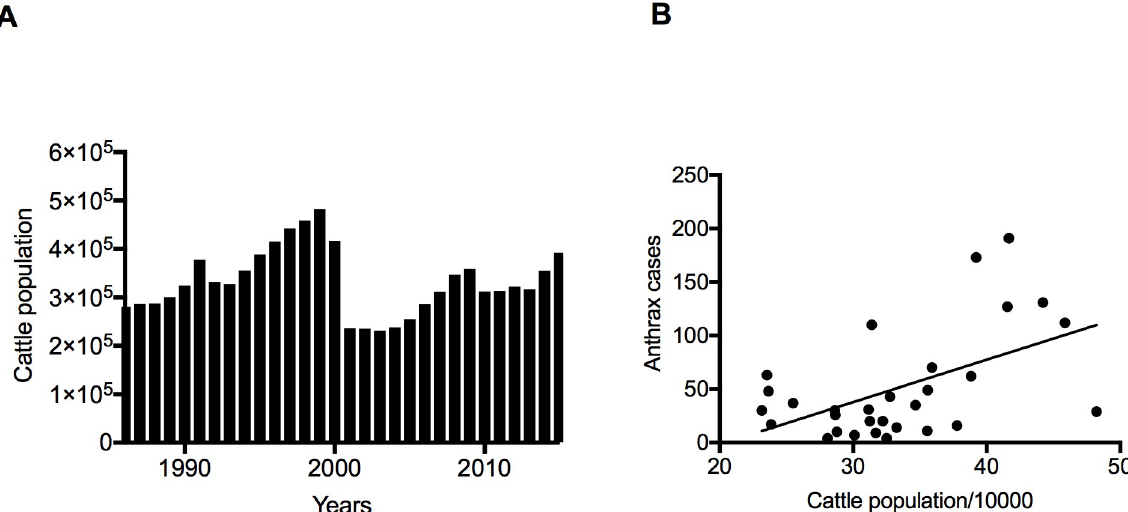
Fig 5. The magnitude of anthrax cases in relation to cattle population. (A) Cattle population by year. (B) Correlation between anthrax cases and cattle population between 1986 and 2015. r = 0.52, p = 0.003, 95% CI 0.2–0.743.